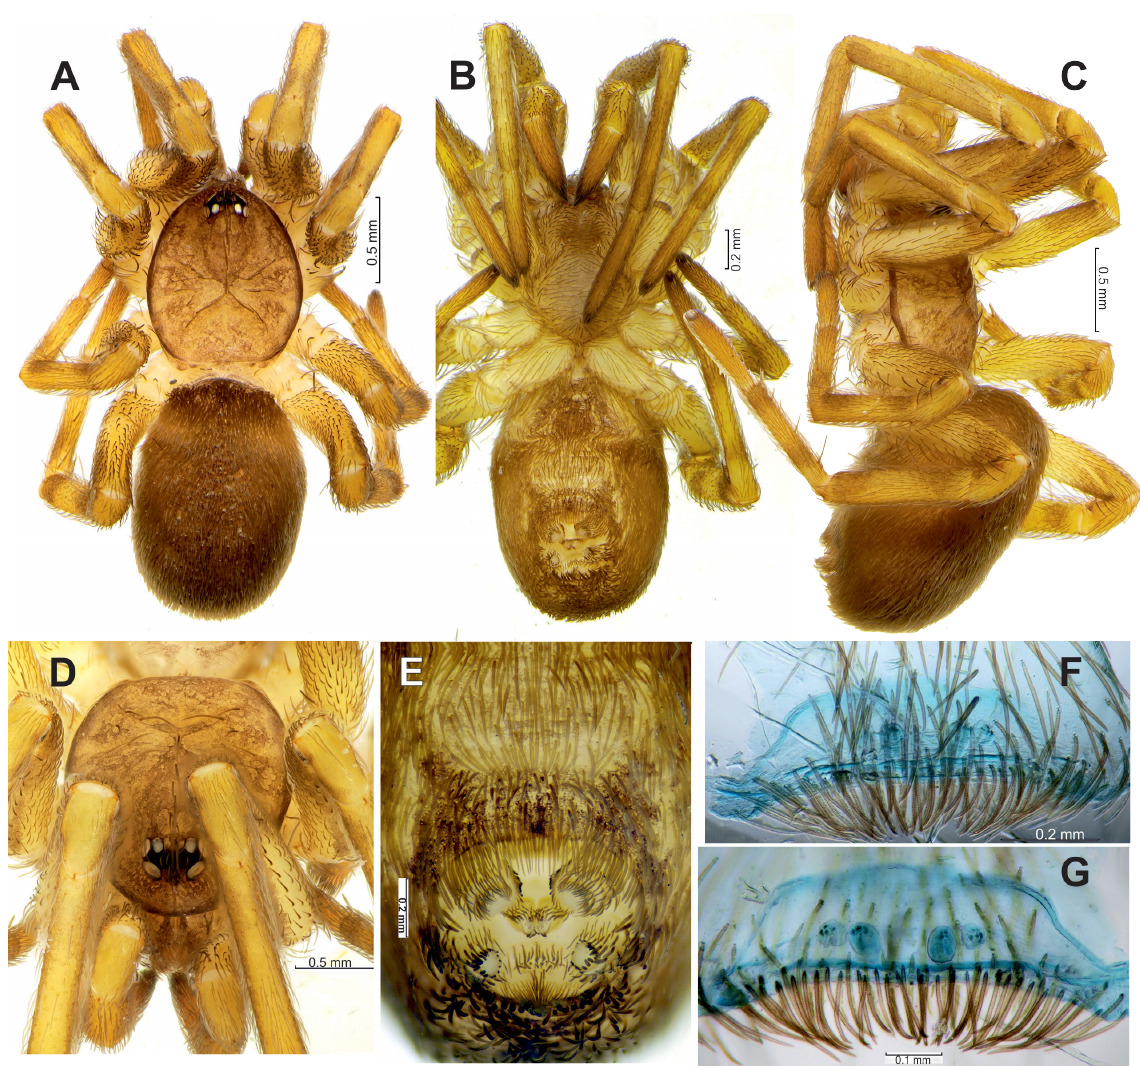
Fig. 11. Somatic characters and endogyne of Zaitunia kunti sp. nov., paratype, ♀ from Cyprus. A – C . Habitus, dorsal, ventral and lateral. D . Prosoma, frontal. E . Posterior part of abdomen, showing tracheal spiracle and spinnerets. F–G . endogyne, ventral and dorsal. Scale bars: a, C–D = 0.5 mm; B, e–F = 0.2 mm; G = 0.1